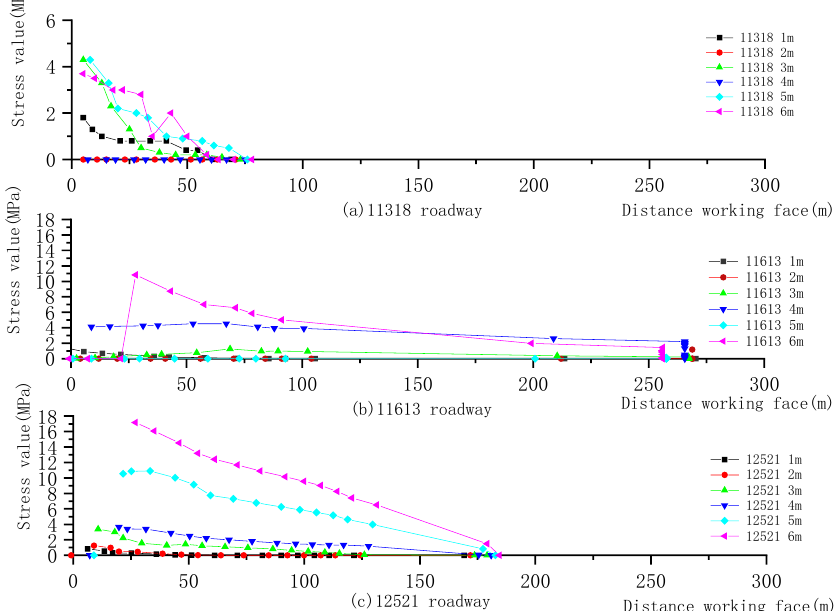
Figure 9. Comparison analysis diagram of vertical stress increment at different depth measuring points in high wall. ( a ) 11318 roadway; ( b ) 11613 roadway;( c ) 12521 roadway.